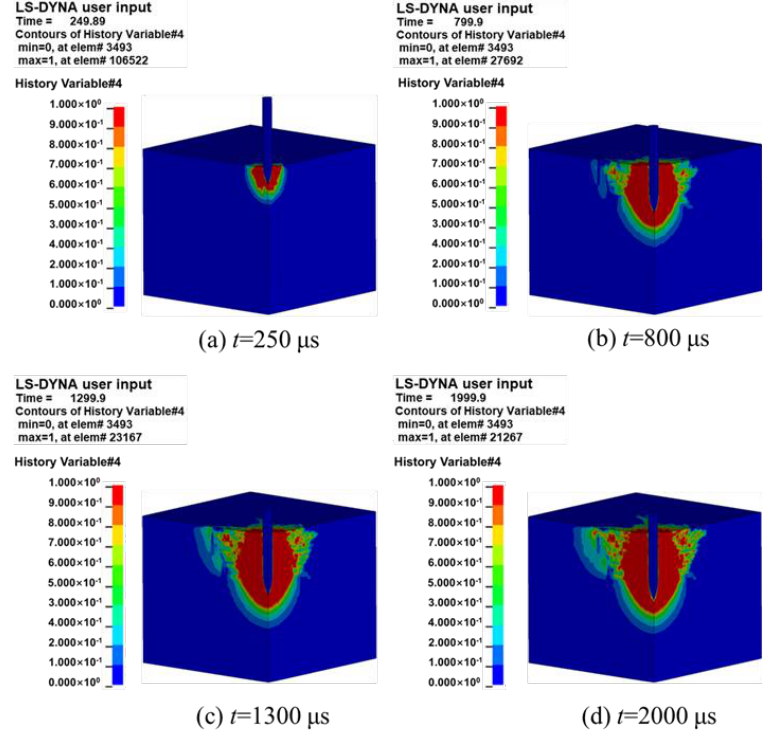
Figure 15. Numerical results of the penetration process for U-1, where the striking velocity is 410 m/s, and the target thickness is 90 cm.